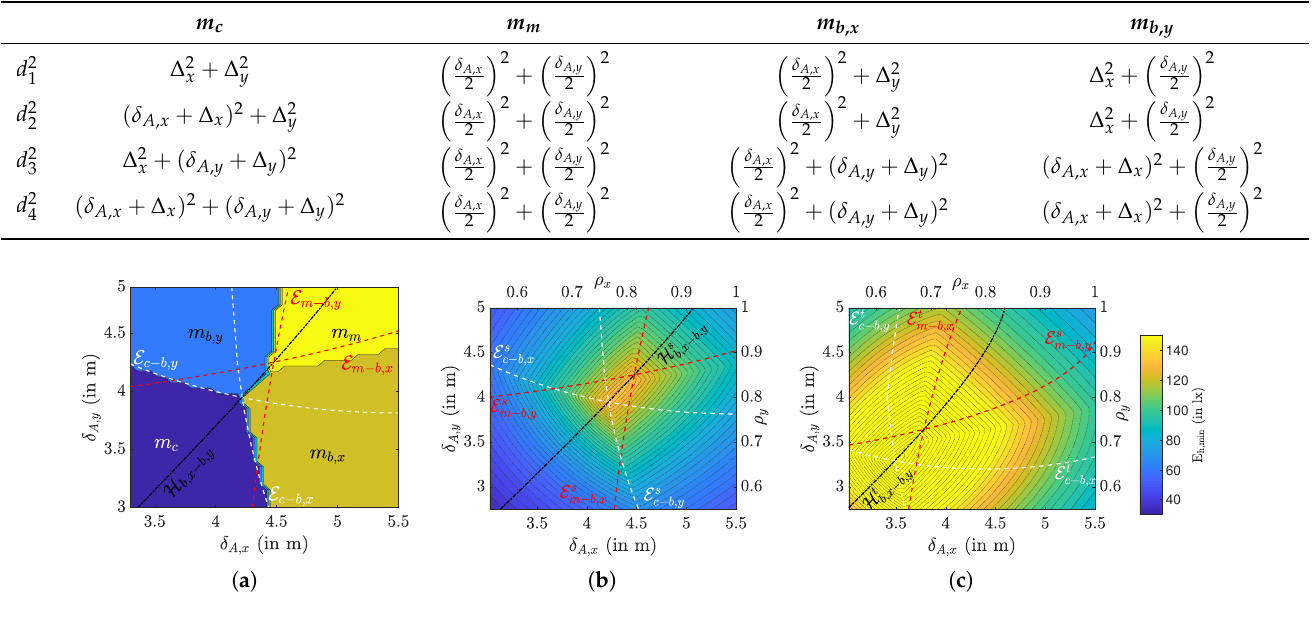
Figure 8. For X max = 11 m, Y max = 10 m, Z max = 2 m, P A , x = 3, P A , y = 3 and m S = 1 ( a ) shows the decision regions for ( m m , m c , m b , x , m b , y ) in the ( δ A , x , δ A , y ) plane to obtain the minimum horizontal illuminance E h,min in both ( b ) the surrounding area and ( c ) the task